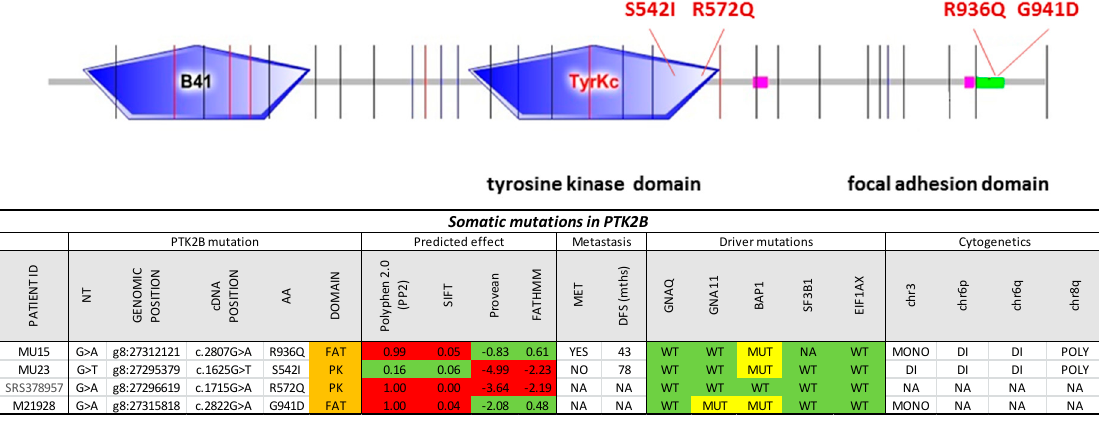
Figure 3. Protein tyrosine kinase 2 beta ( PTK2B ) mutations in uveal melanoma. The entire protein coding sequence of PTK2B is shown. Exon borders are indicated by vertical lines. B41, tyrosine kinase, and focal adhesion kinase domains are indicated by boxes. The table at the bottom shows the characteristics of the mutations, polyphen 2.0, SIFT, PROVEAN, and FATHMM scores, as well as the sample characteristics with regards to known driver mutations and cytogenetic copy number alterations.